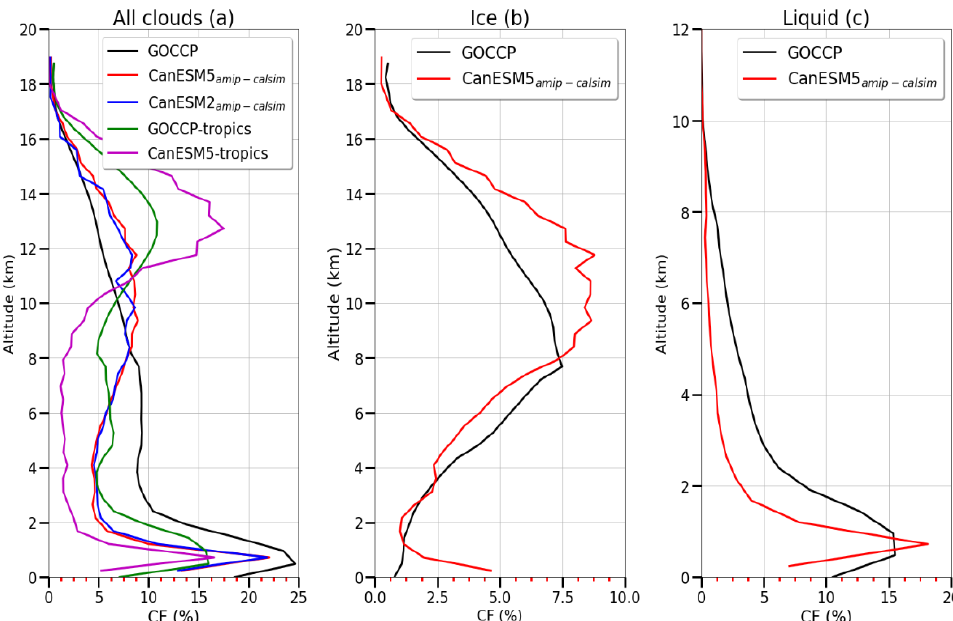
Figure 10. Annually, globally, and horizontally averaged CF for all phase ( a ), ice phase ( b ), and liquid phase clouds ( c ).